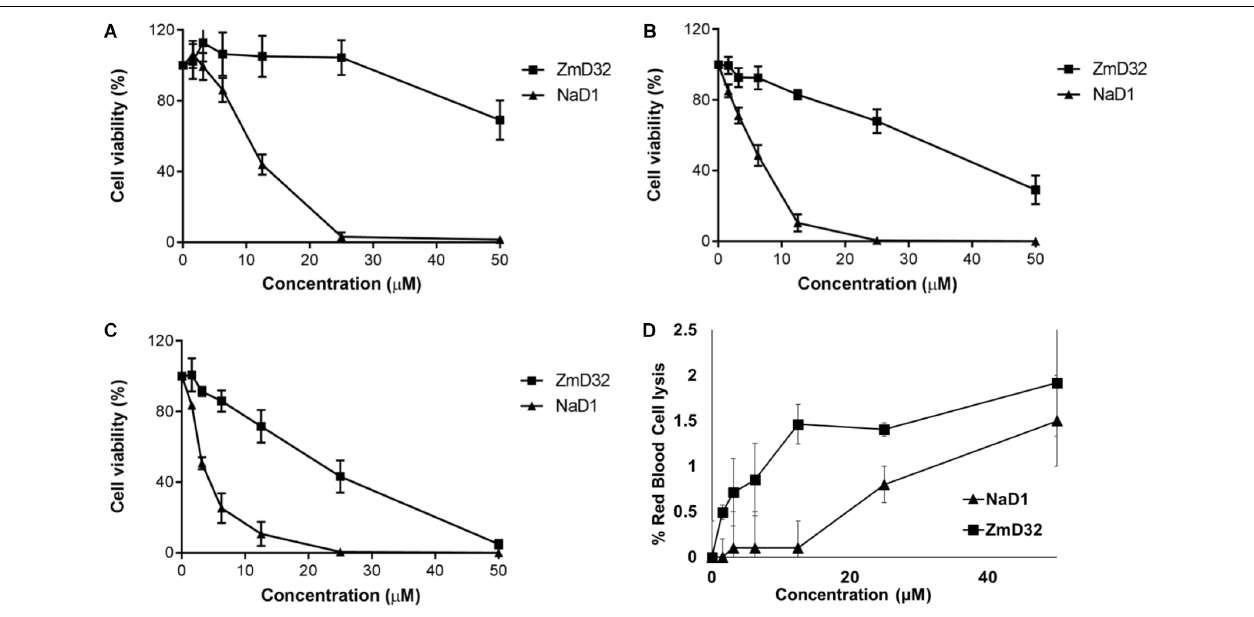
FIGURE 4 | Activity of ZmD32 and NaD1 against human cell lines. (A) AHDF (B) PC3, and (C) U937 cell lines were assayed for viability after incubation with a range of concentrations of ZmD32 and NaD1 for 48 h. NaD1 decreased viability of all three cell lines at much lower concentrations than ZmD32. (D) Hemolytic activity of ZmD32 and NaD1. Neither defensin lysed more than 2% of red blood cells at concentrations up to 50 µ M. Data is the average of three independent replicates, error bars are standard